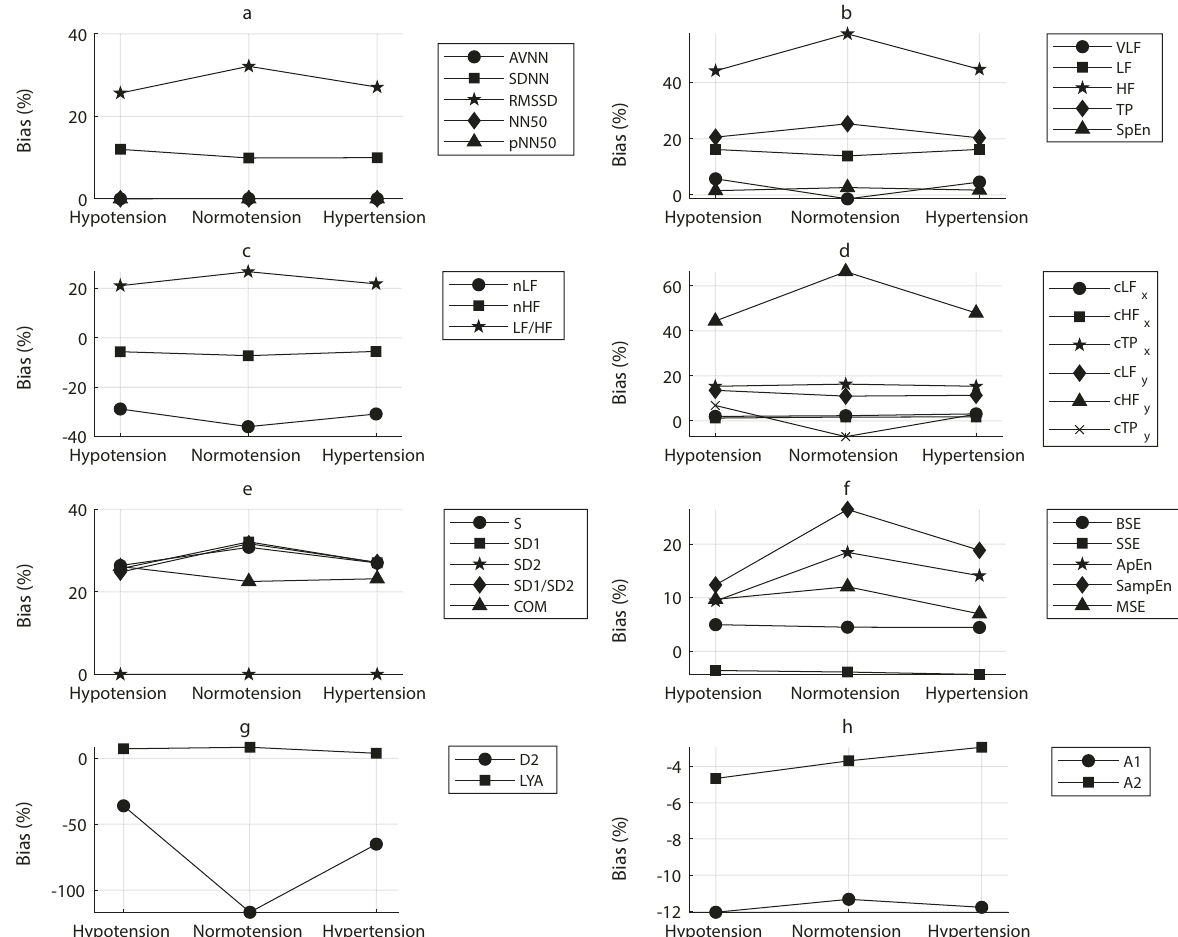
Fig. 2 Bias measured from the Bland – Altman analysis comparing indices extracted from pulse rate variability and heart rate variability. The bias was obtained between measured indices when comparing pulse rate variability and heart rate variability in each blood pressure state (hypotension, normotension, and hypertension) using the Bland – Altman analysis. Indices analysed were a time-domain indices, b absolute and entropy indices from the frequency domain, c relative indices from the frequency domain, d centroid-related indices from the frequency domain, e Poincaré plot indices, f entropy-related indices, g phase-related indices, and h indices resulting from the detrended fl uctuation